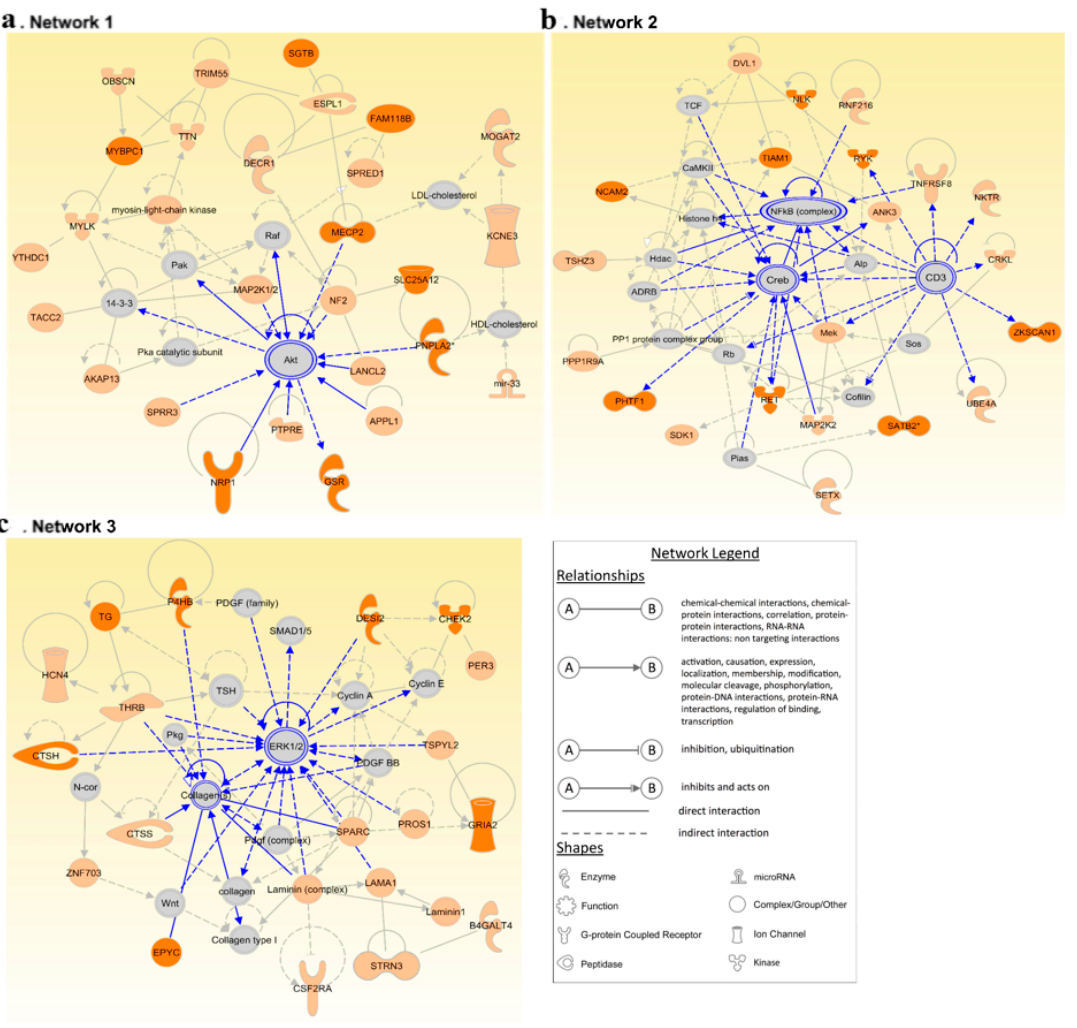
Figure 4. The top three molecular networks identified by Ingenuity Pathway Analysis (IPA): ( a ) Network 1. Protein Synthesis, Cardiovascular System Development and Function, Cellular Assembly and Organization; ( b ) Network 2. Cell Morphology, Cellular Assembly and Organization, Cellular Development and ( c ) Network 3. Endocrine System Disorders, Metabolic Disease, Organismal Injury and Abnormalities. Genes from our input-data that were prioritized based on pedigree segregation and PHRED-like CADD scores are shown in peach. Our top coding and non-coding candidates are highlighted in dark orange. Interactions of central genes of the network are highlighted in blue.